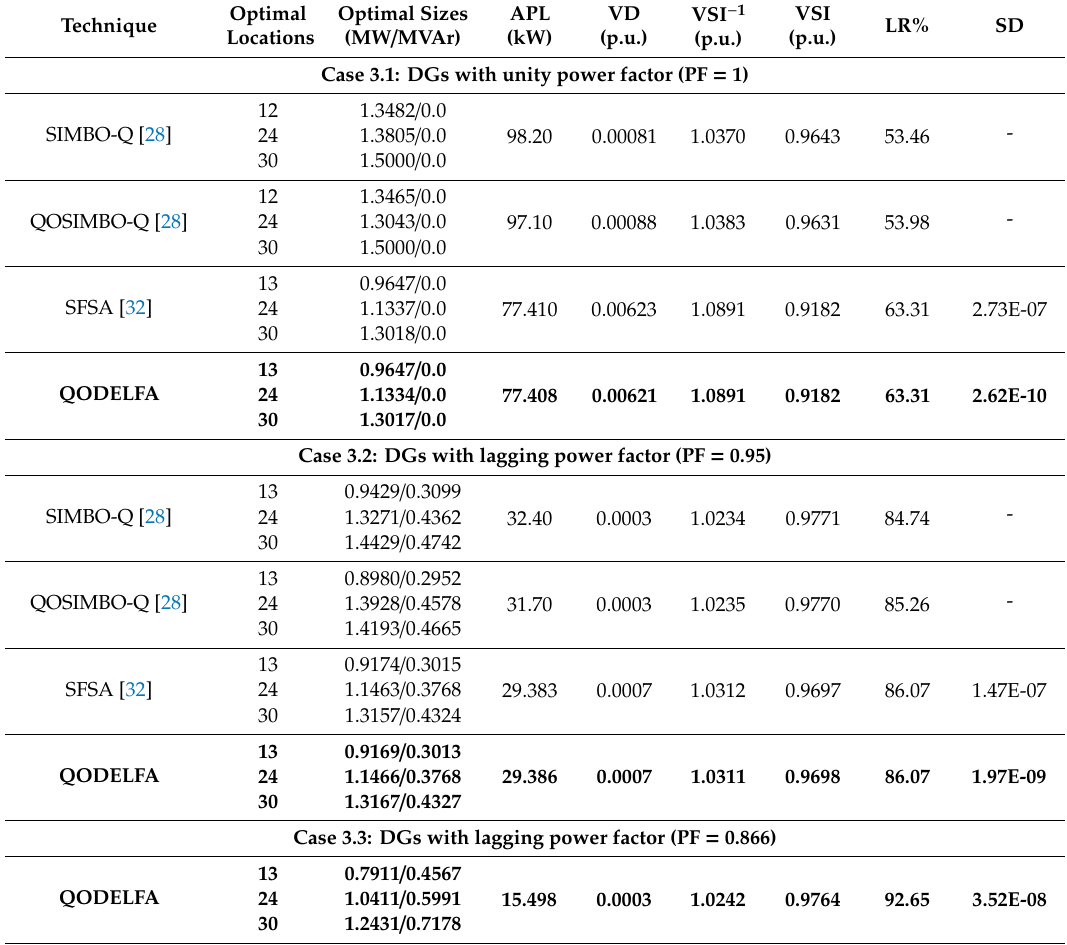
Table 5. Results for the IEEE 33-bus RDS with simultaneous minimization of OF 1 , OF 2 , and OF 3